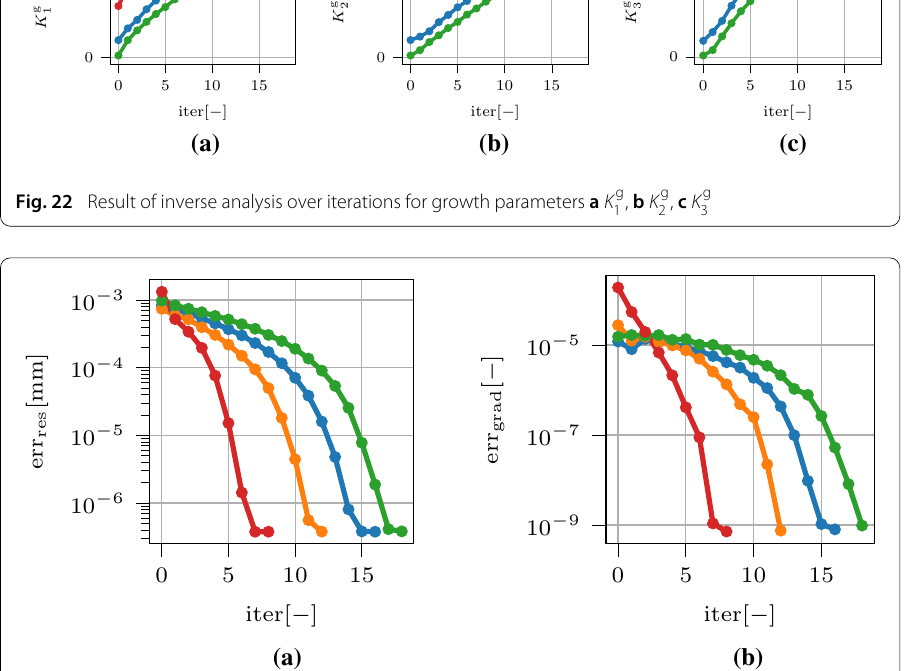
Fig. 23 Errors over iterations for growth inverse analysis a residual error err res , b gradient based error err grad